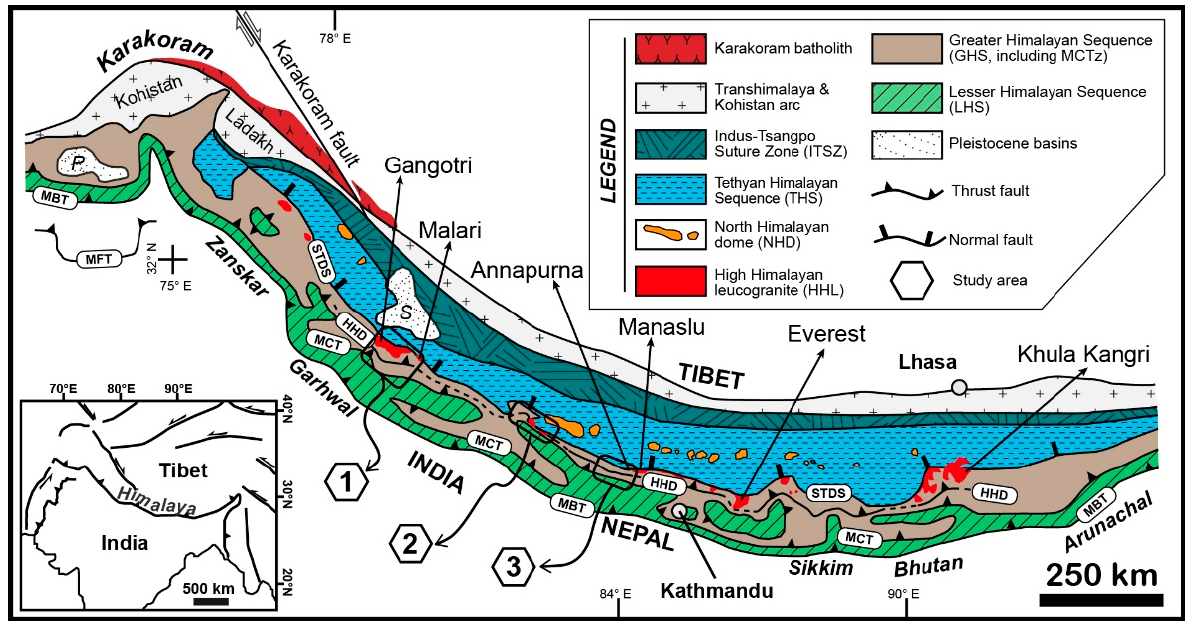
Figure 2. Geological map of the Himalaya (modified from Weinberg, 2016 [24]). Abbreviations: MFT, Main Frontal Thrust; MBT, Main Boundary Thrust; MCT, Main Central Thrust; HHD, High Himalayan Discontinuity; STDS, South Tibetan Detachment System; P, Peshawar basin; S, Sutlej basin. (1) Badrinath Shear Zone (NW India); (2) Tojiem and Mangri Shear Zones (west Nepal); (3) Chomrong Thrust (central Nepal).